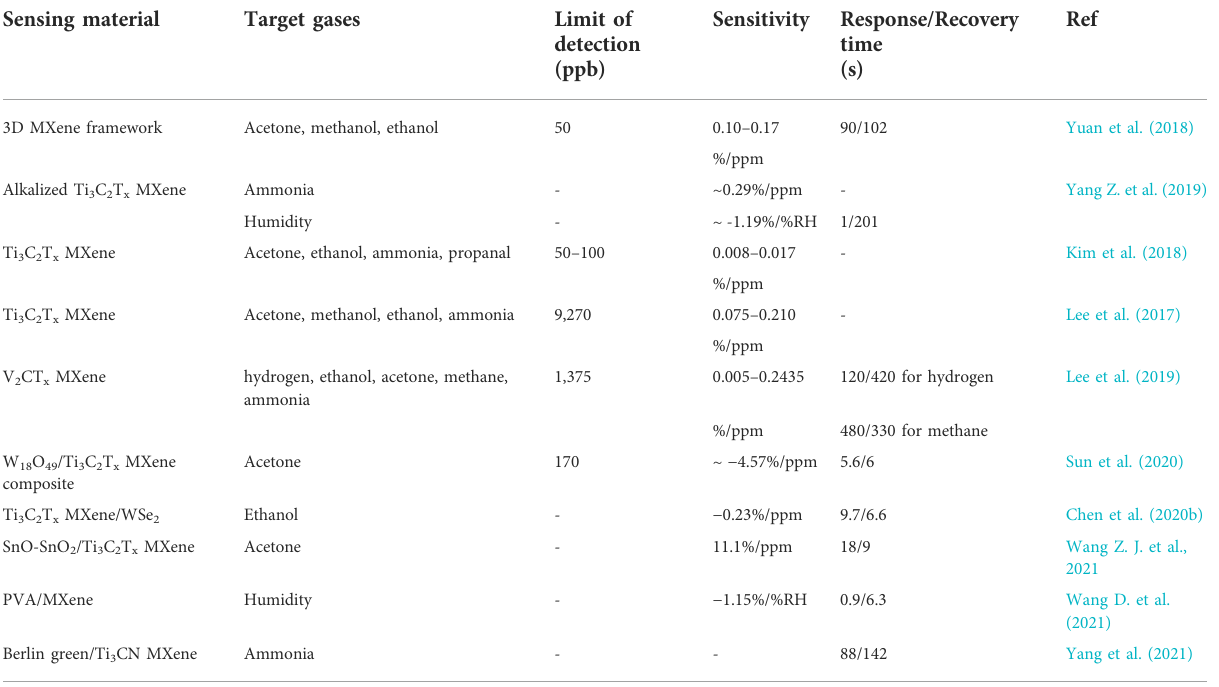
TABLE 3 Summary of MXene-based gas